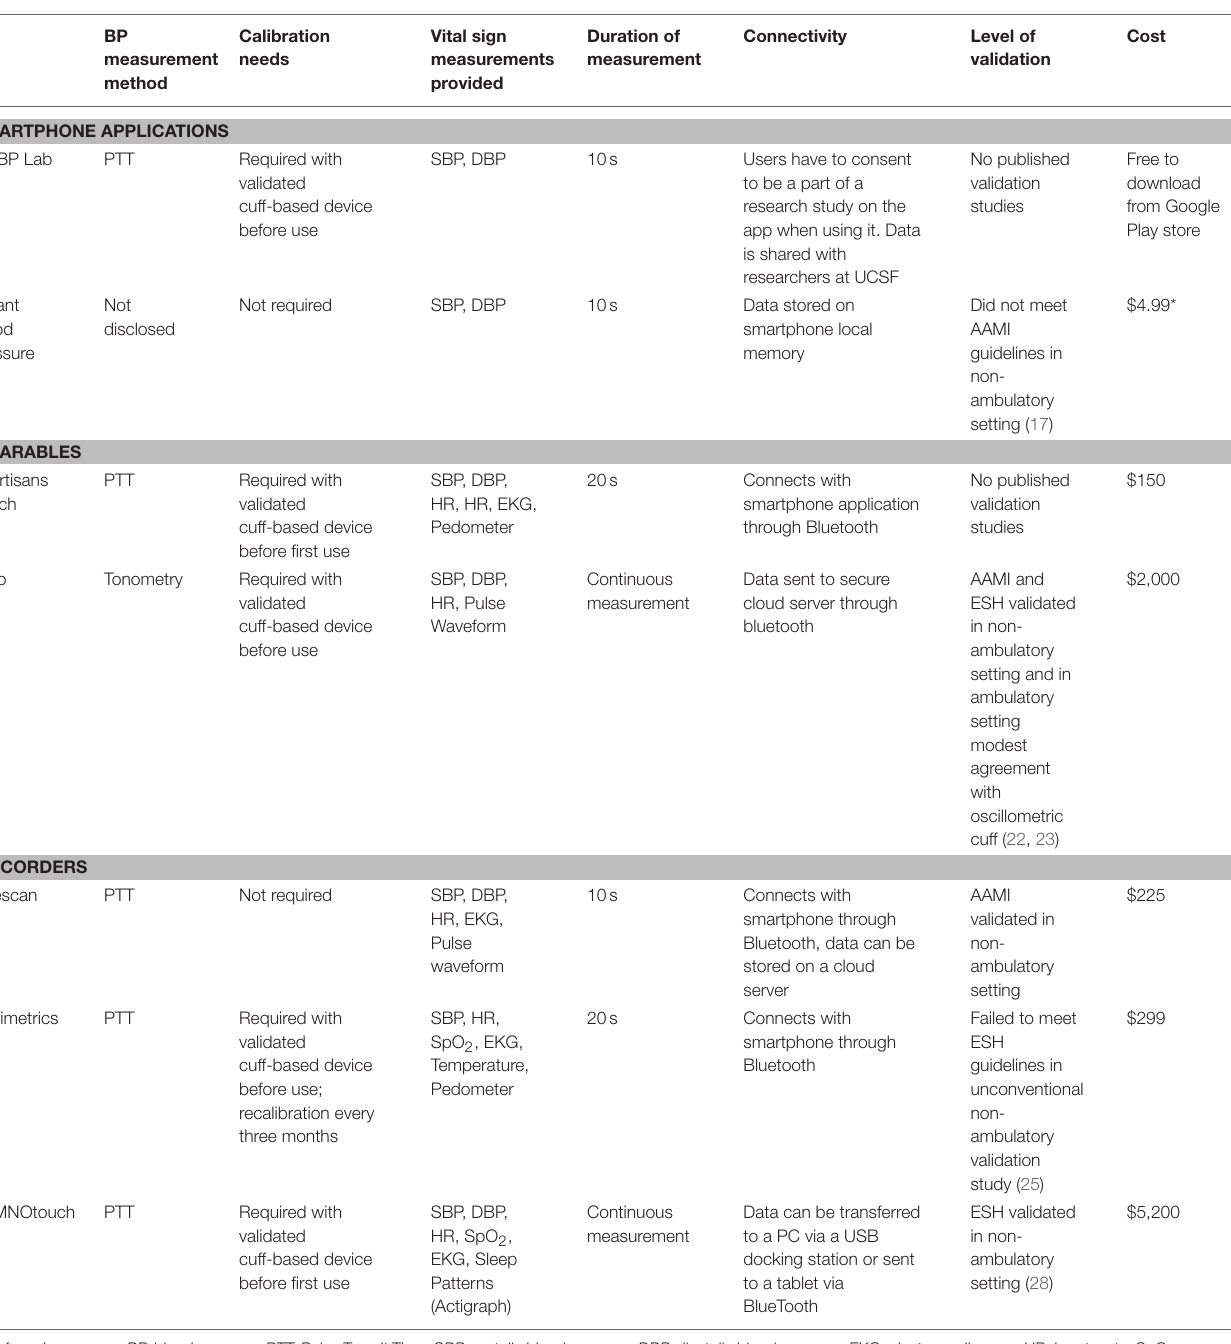
TABLE 1 | Cuff-less devices for BP